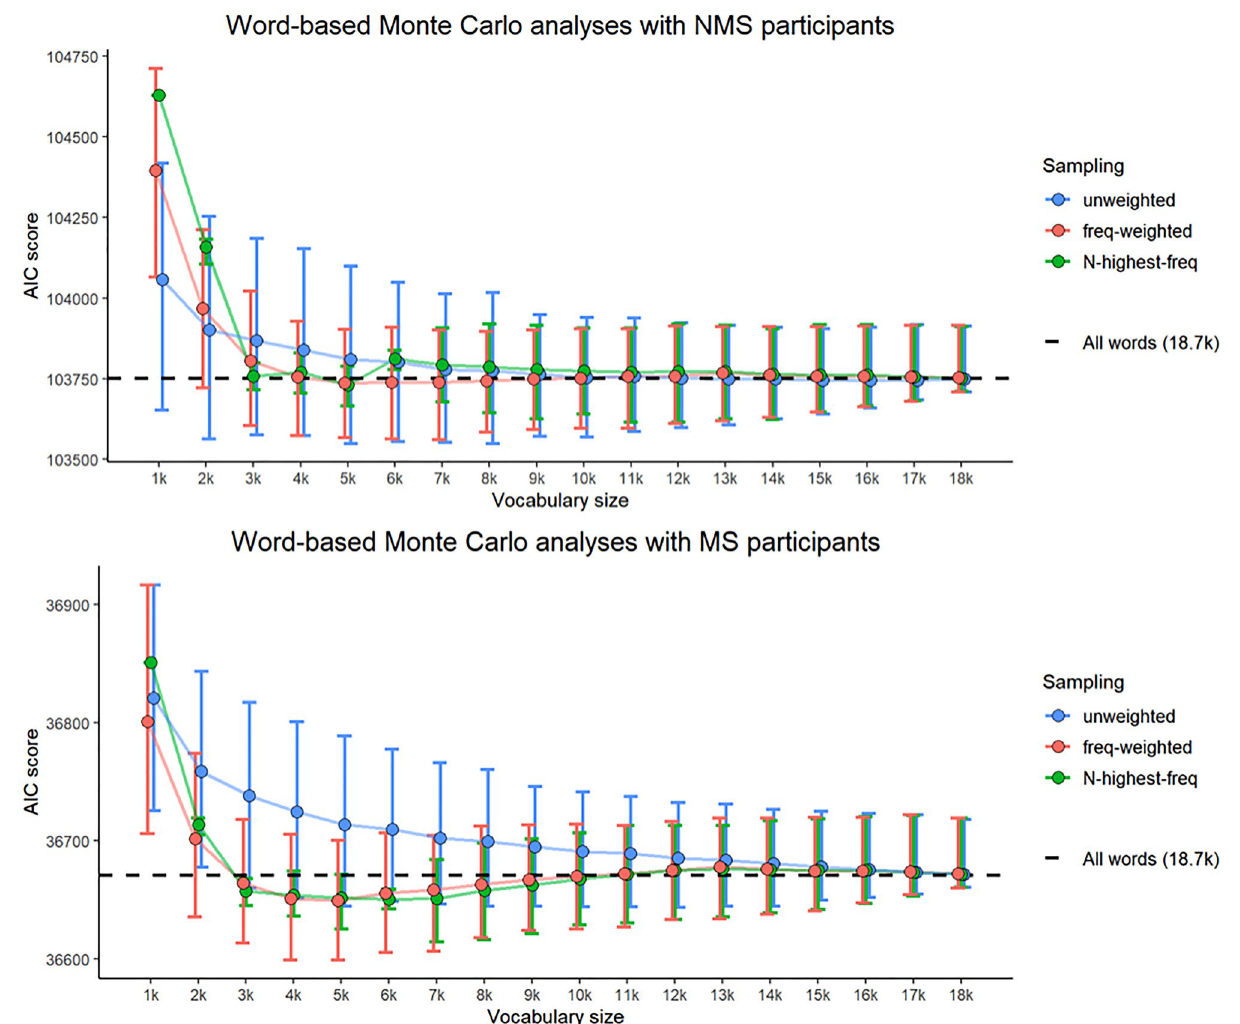
Figure 3. Monte Carlo Simulations with 1,000 samples for each vocabulary size. Lower AIC score indicates greater ability to predict participants’ well-formedness judgements. The black dashed line shows the AIC score of a model that assumes phonotactic knowledge generated from the full dictionary of 18,703 words. The error bars represent 95% bootstrap percentile